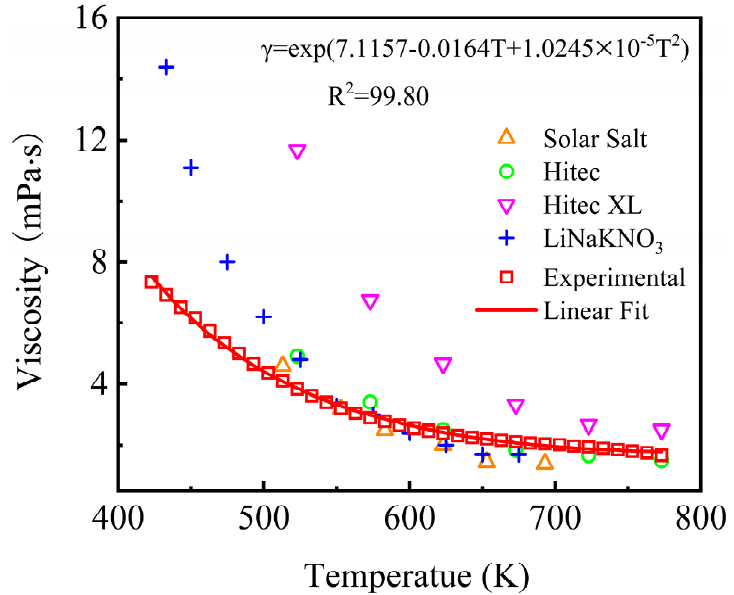
Figure 11. Viscosity of the NaNO 3 -KNO 3 -Ca(NO 3 ) 2 (16:48:36 wt%) eutectic ternary salt and other currently used nitrate/nitrite systems.